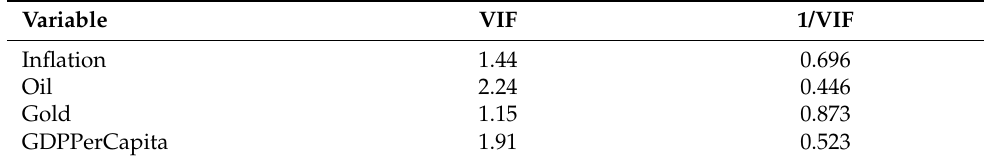
Table 3. The variance inflation factor.